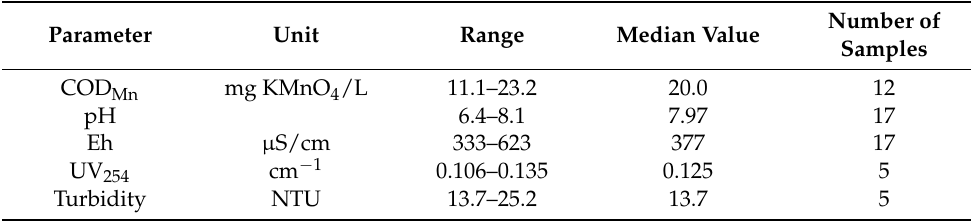
Table 3. Characteristics of the river